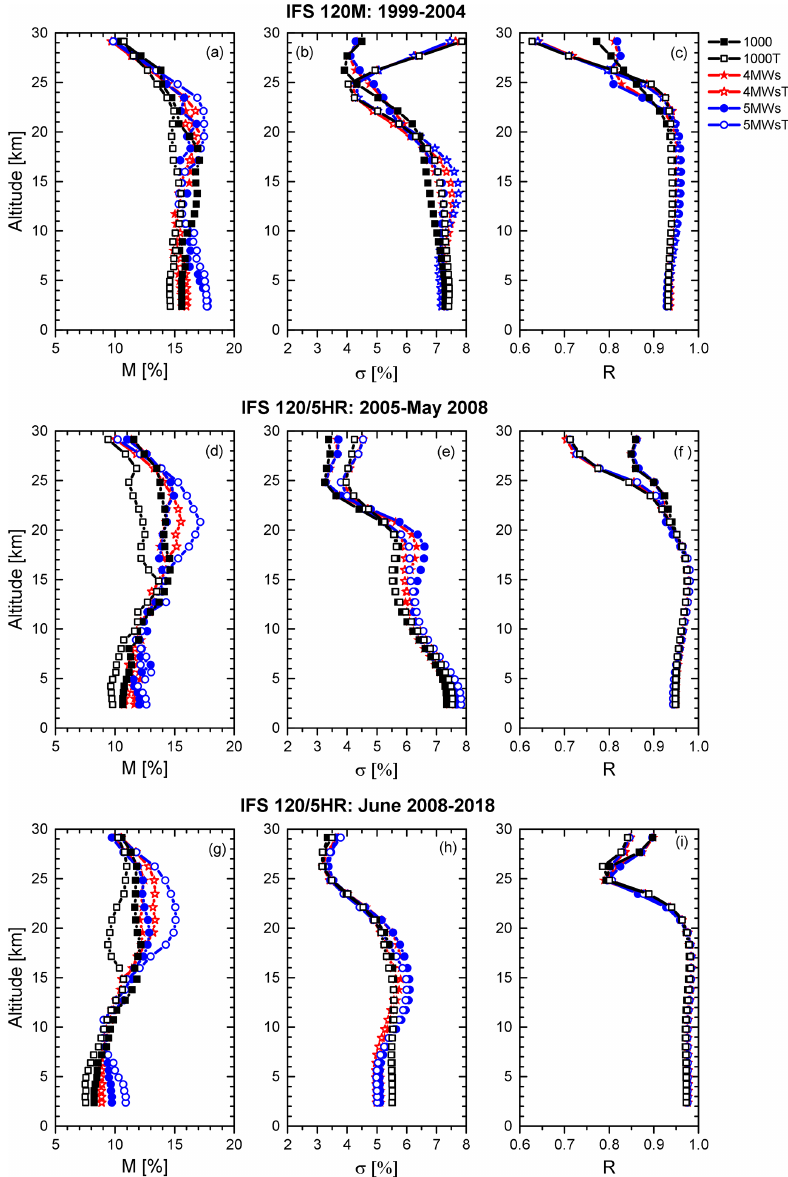
Figure 7. Summary of the FTIR–smoothed ECC comparison for the periods 1999–2004, 2005–May 2008, and June 2008–2018. Panels (a) , (d) , and (g) display the vertical profiles of median ( M ) RD (FTIR–ECC, in %) for the three periods, respectively. (b, e, h) As for (a) , (d) , and (g) , but for the standard deviation of the RD distribution ( σ , in %). (c, f, i) As for (a) , (d) , and (g) , but for the Pearson correlation coefficient. The number of coincident FTIR–ECC measurements is 56, 49, and 167 for the periods 1999–2004, 2005–May 2008, and June 2008–2018,